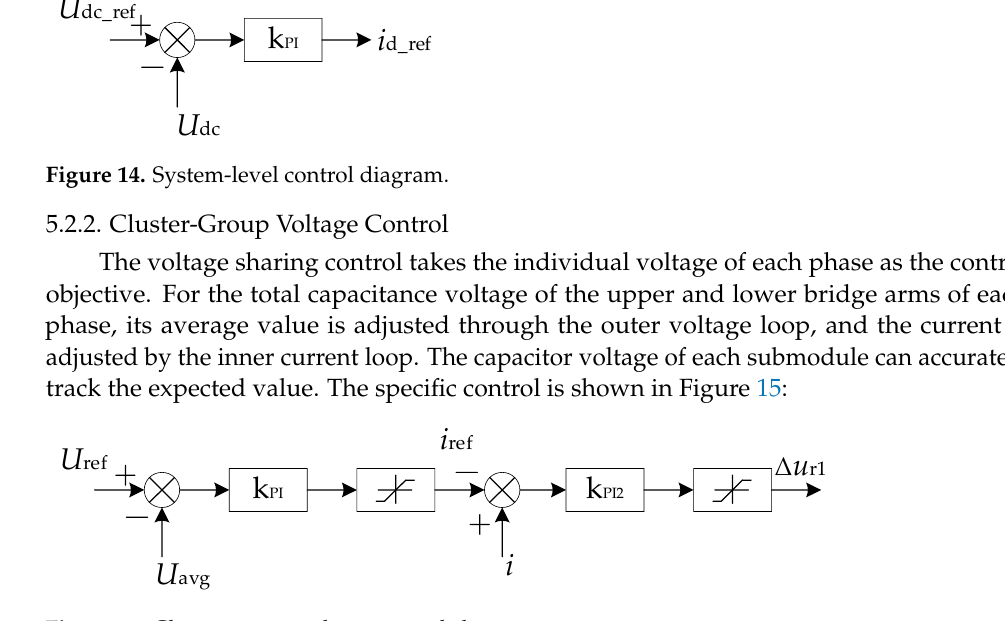
D Figure 13. Control chart of VSG-DFC. 5.2. DC Voltage Three-Level Control on Rectifier Side Since each MMC submodule has an independent capacitor, it is necessary to balance and stabilize the capacitor voltage of the submodule, which is the prerequisite for the reliable operation of the MMC system. According to the characteristics of the MMC rectifier, a hierarchical control strategy including the system-level control, cluster-group voltage control, and inter-cluster voltage control was applied, and it was combined with carrier Phase-Shift Modulation (PSM). The capacitor voltage of the MMC submodule can